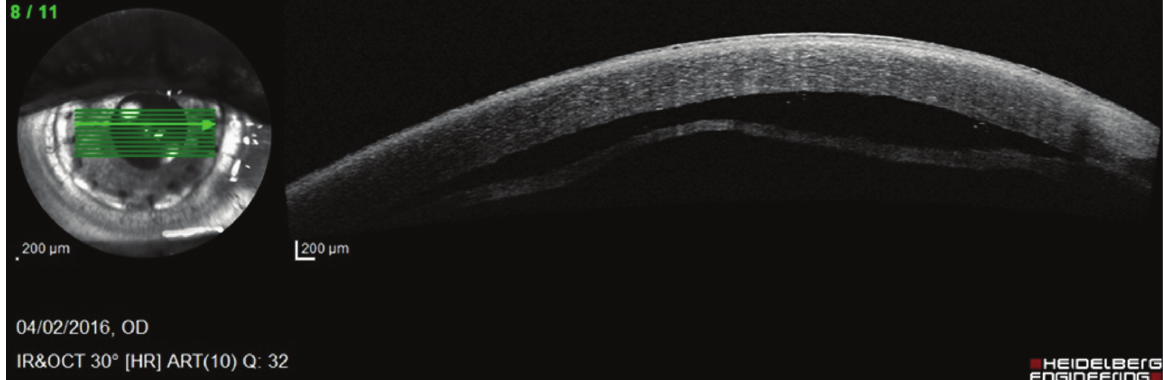
Figure 1. Anterior segment optical coherence tomography showing separation of anterior lamellar graft and posterior lamella.